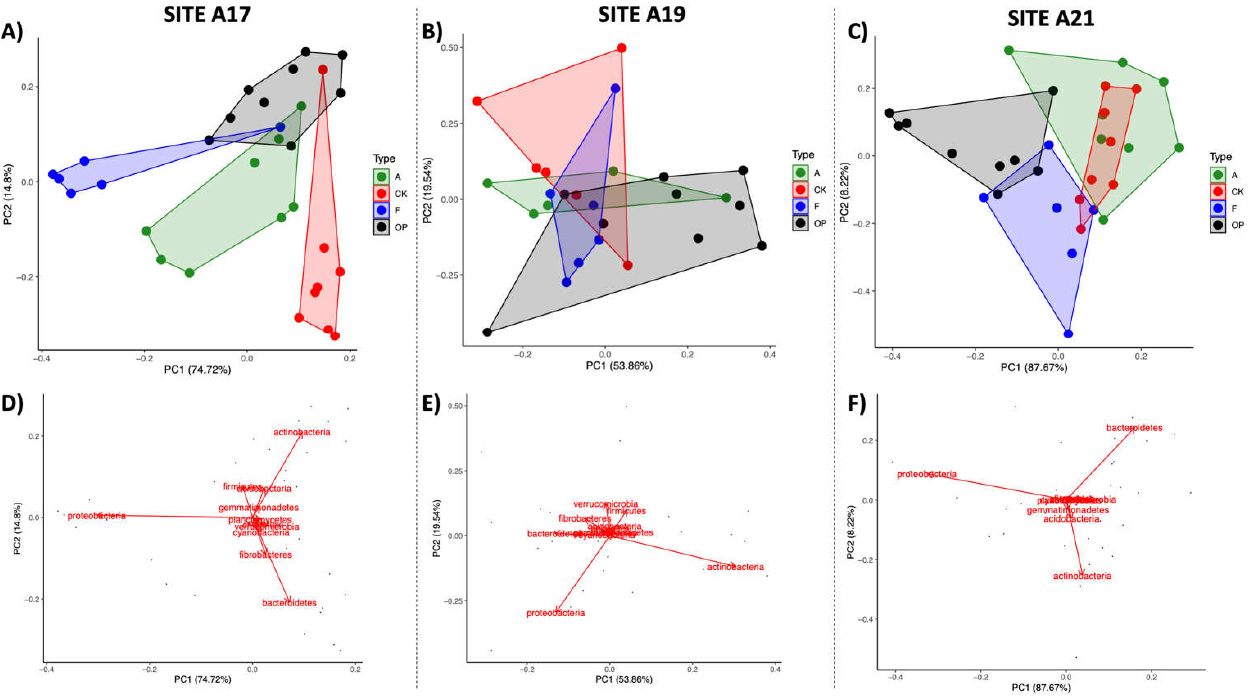
Figure 3. Principal components analysis of the four dune microhabitat (blowout (OP), A. breviligulata ( A ), C. kobomugi (CK), and foredune toe ( F )) microbiomes based on percentage community composition at the phylum level. Analysis was performed separately for sites A17 ( A ), A19 ( B ), and A21 ( C ), with arrows representing the vectors of factor loadings of key genera ( D – F , respectively). The percent variation explained by the PCs of each principal components analysis is indicated on the axes.